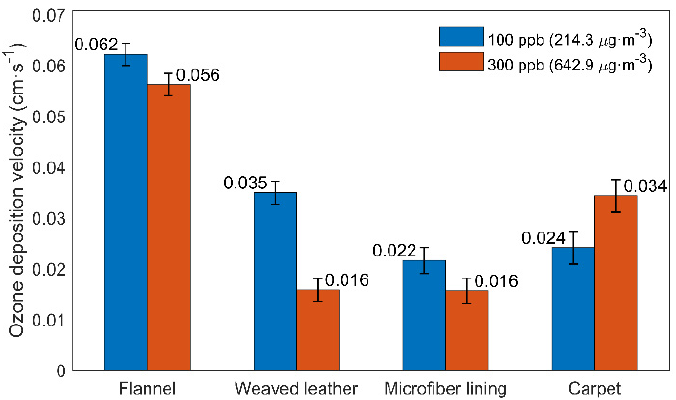
Figure 4. Ozone deposition velocities at a steady state on synthetic fibers.